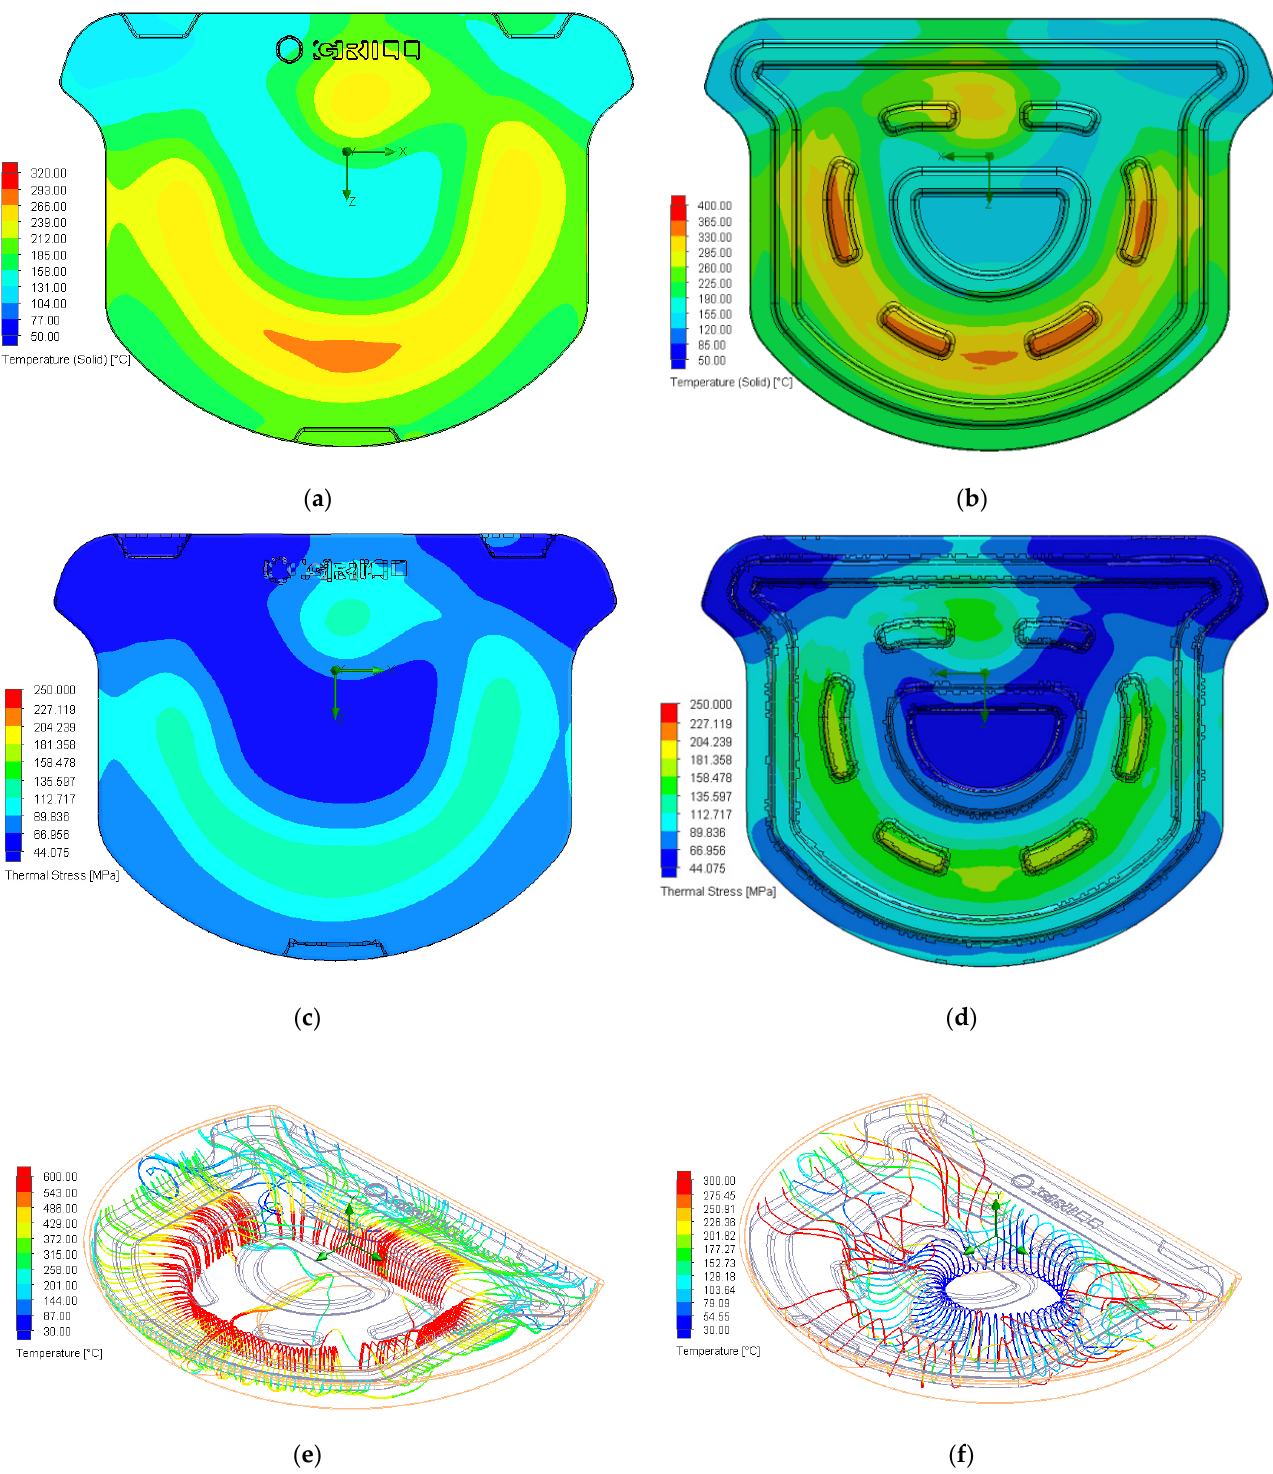
Figure 13. CA#2 stone grill plate. Temperature distribution on the ( a ) surface and ( b ) bottom of the plate. Thermal stress distribution on the ( c ) upper surface and ( d ) bottom of the stone grill plate. ( e ) Burner streamline distribution (temperature); ( f ) Air inlet streamline distribution (temperature).